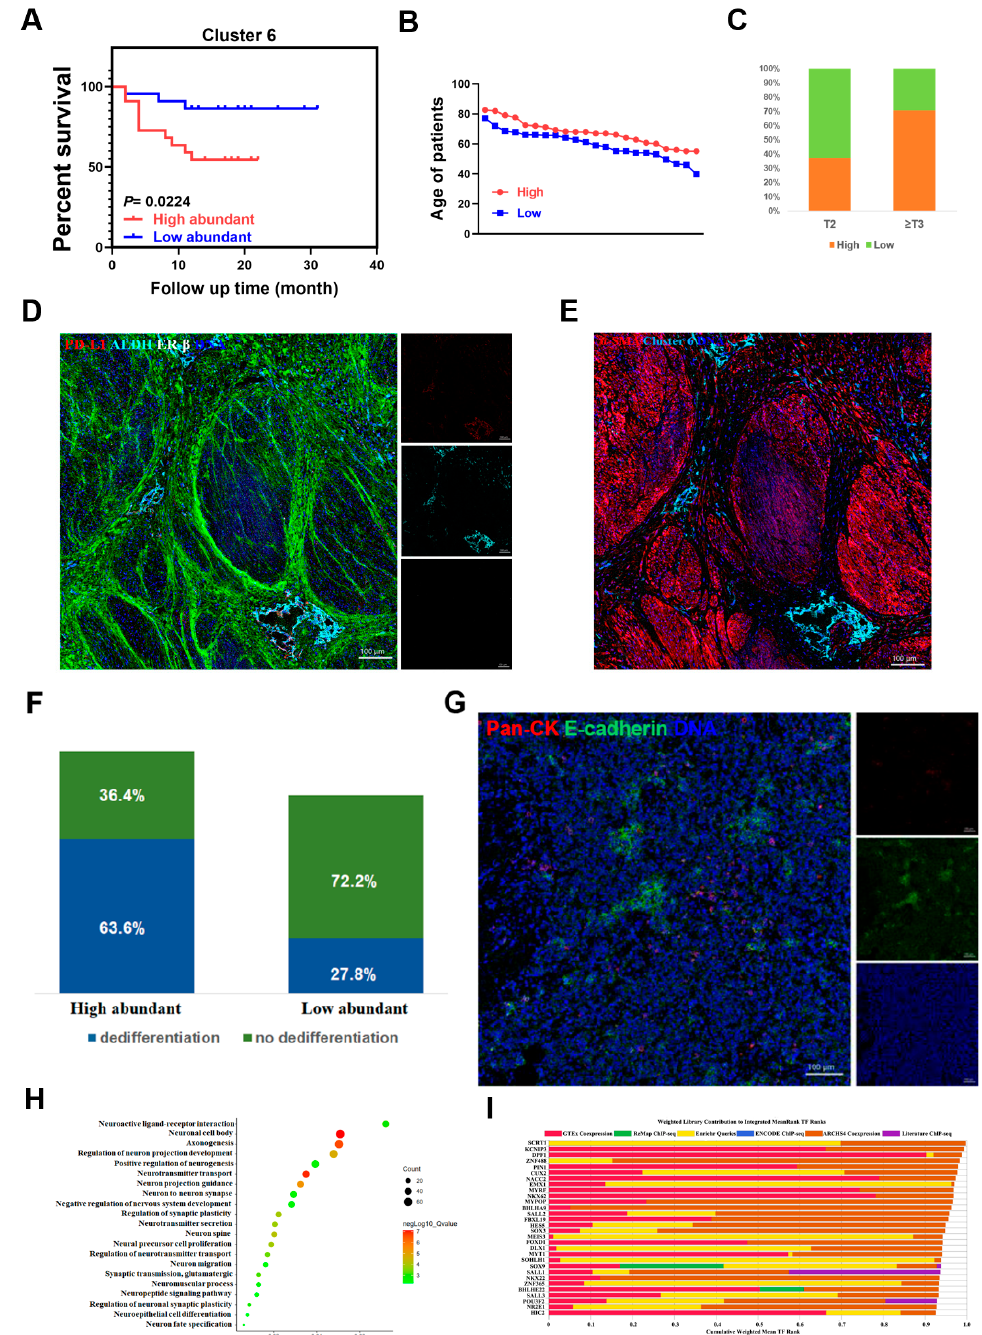
Figure 3. A specific cancer stem-like cell cluster associates with poor prognosis. ( A ) Survival curves show distinctive prognosis of patients in cluster 6 high- and low-abundance group. ( B ) Line plot shows that cluster 6 high-abundance group patients are older than low-abundancy group patients. ( C ) Histogram reveals that the advanced stage patients always belong to cluster 6 high-abundance group. ( D ) Highlighting the position of cluster 6 by ALDH (cyan), PD-L1 (red), ER- β (white), while collagen I presents as green, DNA presents as blue, scale bars are indicated in images. ( E ) IMC analysis reveals that cluster 6 has invaded into muscular layer; cluster 6 presents as cyan, α -SMA presents as red. ( F ) Frequency of dedifferentiation samples in cluster 6 high- and low-abundance groups. ( G ) Images of dedifferentiated tumor cells, Pan-CK presents as red, E-cadherin presents as green, DNA presents as blue. ( H ) Gene ontology (GO) analysis shows that the DEGs of cluster 6 high- and low-abundance groups enrich in neuro-related pathways. ( I ) Transcription factor enrichment analysis reveals the top 30 potential transcription factors of the DEGs between cluster 6 high- and low-abundance